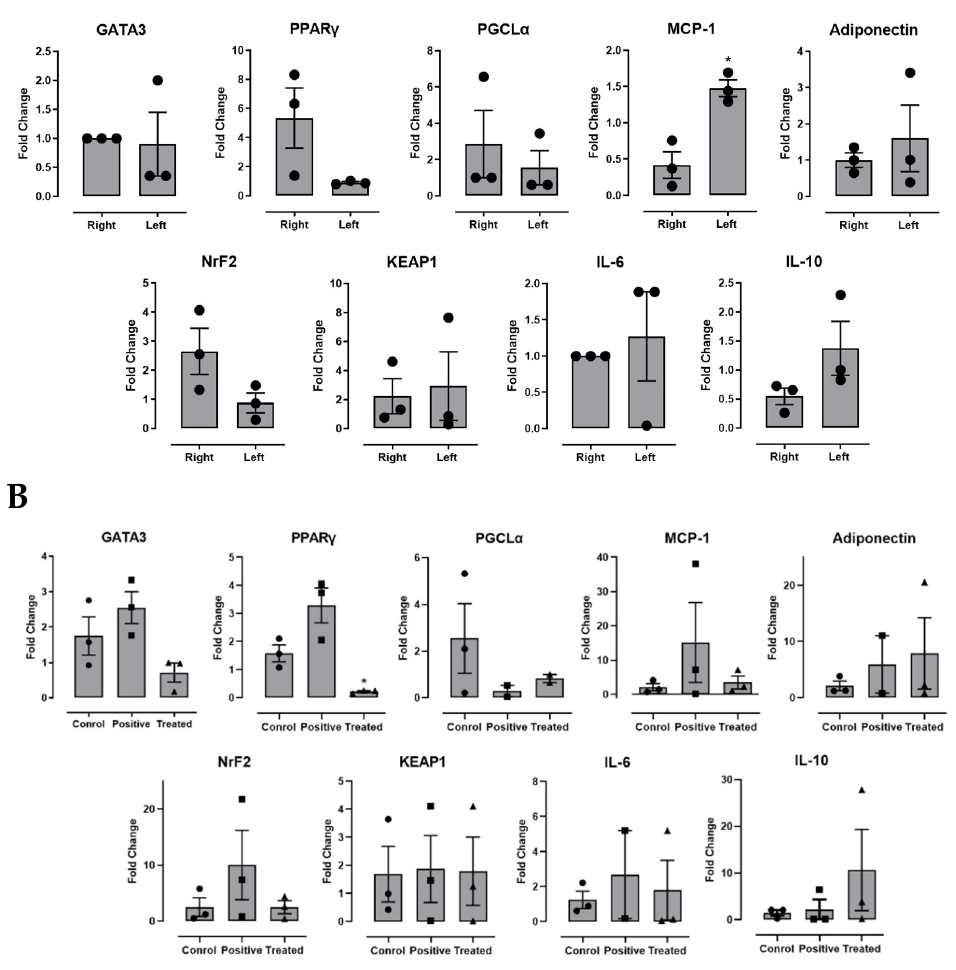
Figure 4. Gene expression in the stromal vascular fraction derived from GATA-3 inhibitor-treated animals. ( A ) SAT at right (treatment site) and left (opposite control side) sites and ( B ) omental adipose tissue in vehicle control, positive control, and GATA-3 inhibitor-treated animals. Differences in gene expression levels were compared for GATA3, PPAR γ , PGC1alpha, MCP-1, Adiponectin, NrF2, KEAP-1, IL-6, and IL-10. Data are presented as mean ± SEM for n = 6 replicates from 3 animals each. Statistical analysis for was determined by ( A ) paired t -test and ( B ) ANOVA (* p < 0.05).